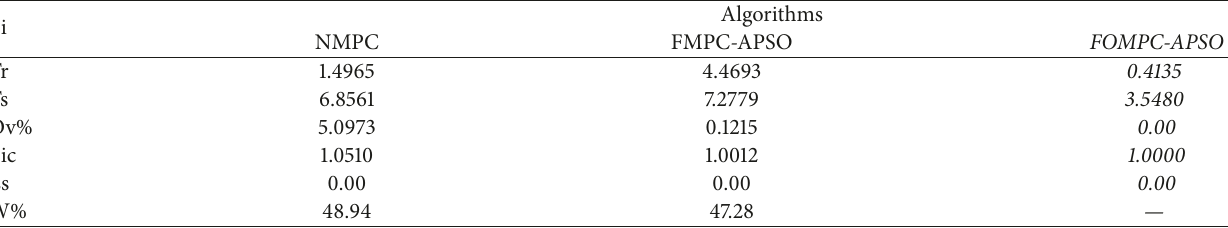
Table 5: Pi found by different methods.